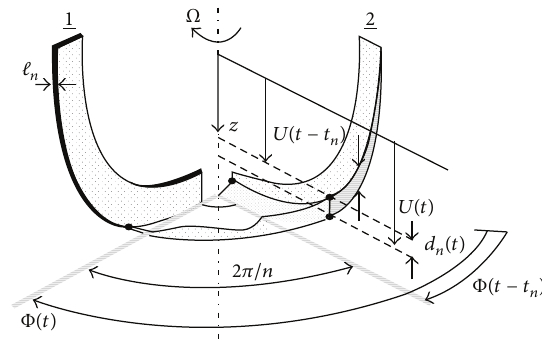
Figure 3: Section of the bottom hole profile located between two successive blades